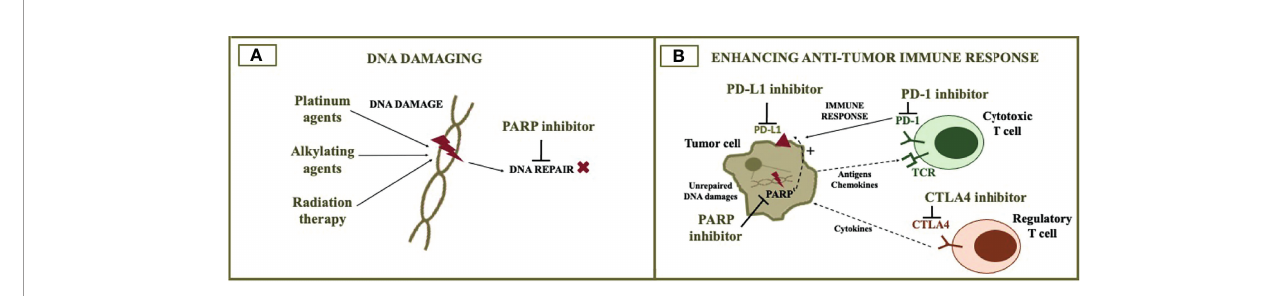
FIGURE 2 | PARP inhibitor combination with cytotoxic agents and immunotherapy. The fi gure illustrates the rationale for combining PARP inhibitors with DNA damaging agents (A) and immunotherapy (B) . DNA damaging agents such as cytotoxic chemotherapy and radiotherapy increase DNA damage, when DNA repair is impaired by the PARP inhibitor. The addition of immune checkpoint inhibitors to the PARP inhibitor can potentially optimize anti-tumor immune response. PARP, poly (ADP-ribose) polymerase; PD-L1, programmed death-ligand 1; PD-1, programmed cell death protein 1; CTLA4, cytotoxic T-lymphocyte associated